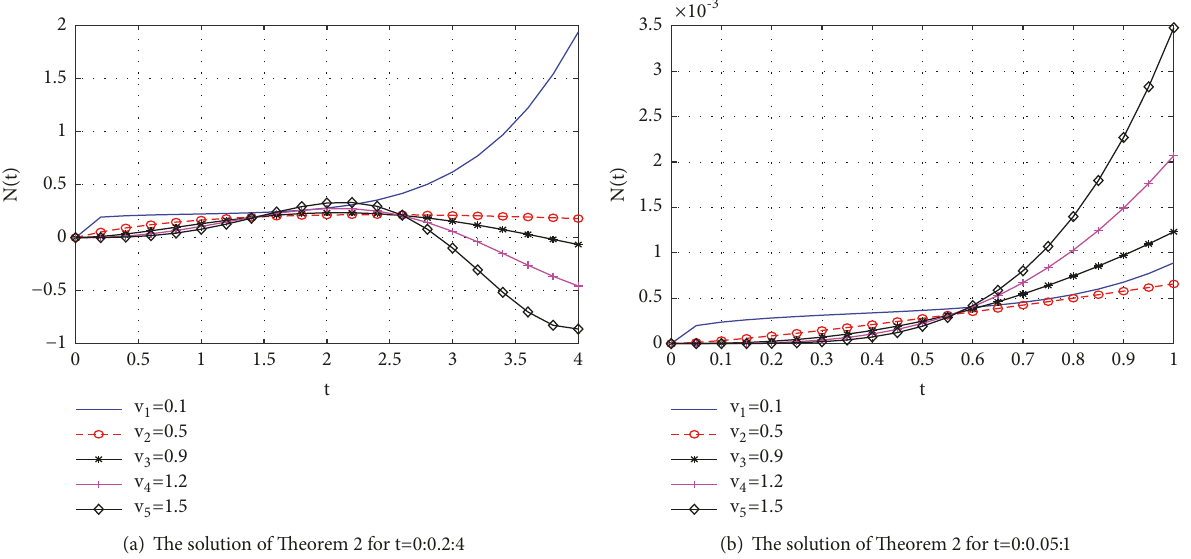
Figure 2: Solution of fractional kinetic equation (28).